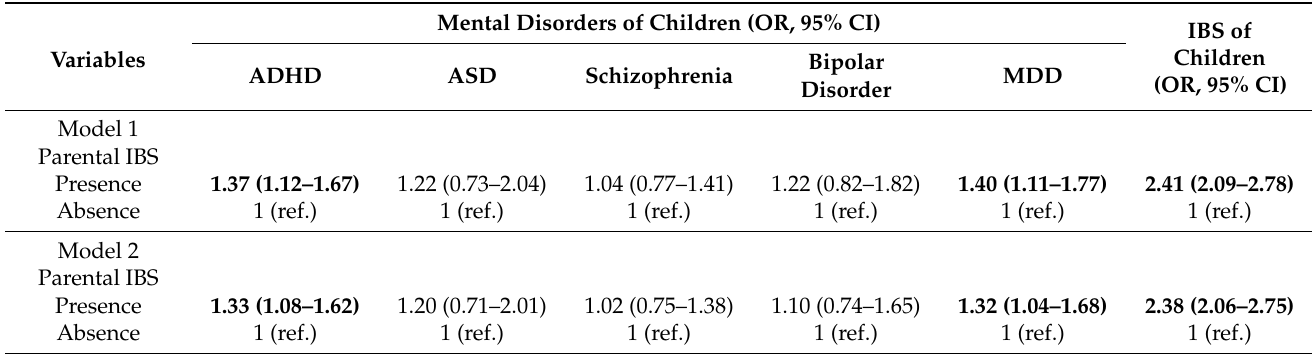
Table 2. Logistic regression model of parental IBS and mental disorders of their